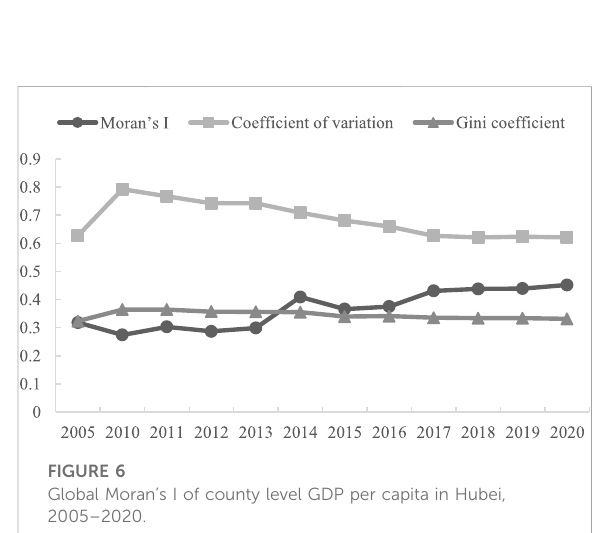
FIGURE 6 Global Moran ’ s I of county level GDP per capita in Hubei, 2005 –